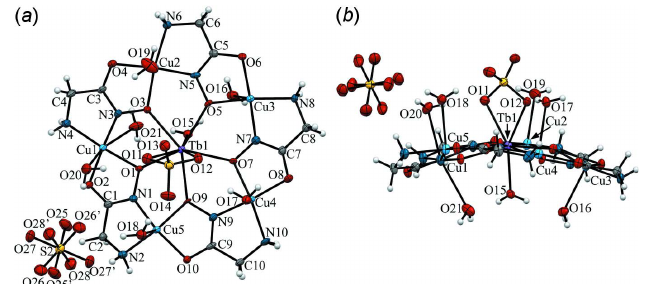
Figure 2 Structure of the [TbCu 5 (GlyHA) 5 (SO 4 )(H 2 O) 6.5 ] + metallacrown cations in 1 . The dashed lines indicate the disorder of the non-coordinated sulfate anion. Displacement ellipsoids are shown at the 50% probability level. [Symmetry code: (i) x , y , z +